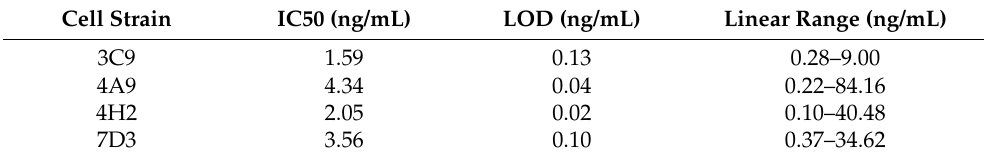
Figure 5. Affinity constants of mAbs secreted by 4 cell lines. ( A ) 3C9; ( B ) 4A9; ( C ) 4H2; ( D ) 7D3. Different colors represent different concentrations of coated antigen. Table 1. Comparison of detection characteristics of monoclonal antibodies secreted by four cell lines.